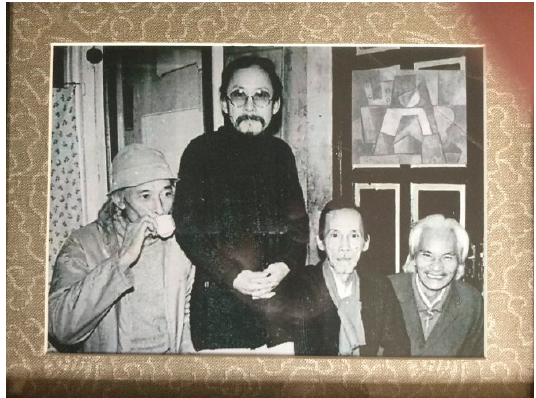
Figure 7. The doctoring image from Jean-François Hubert. The image was sourced from Tuoi Tre Newspaper (Vy 2016).